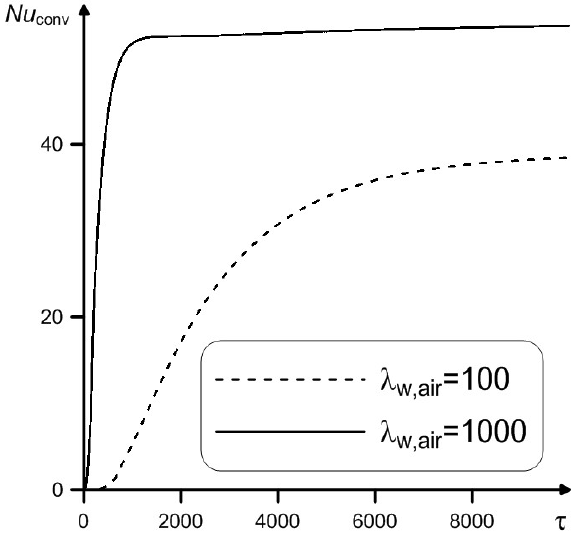
Figure 10. Time profiles of the average convective Nu vs. thermal conductivity ratio at ε = 0.9, Ra = 10 9 , Pr = 0.7, h/L =